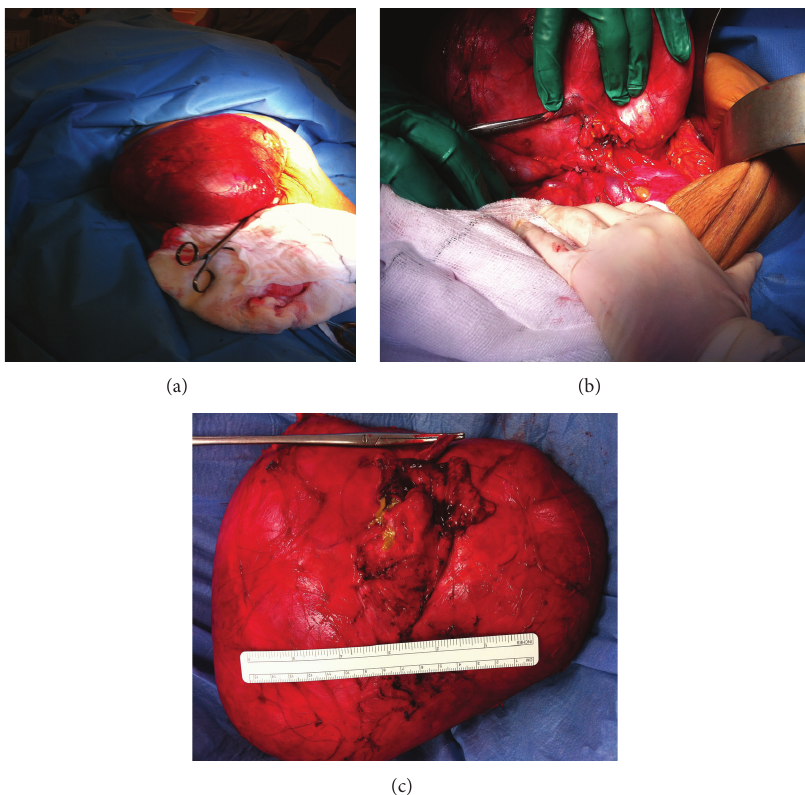
Figure 3: The giant teratoma at laparotomy ((a) and (b)) and after excision